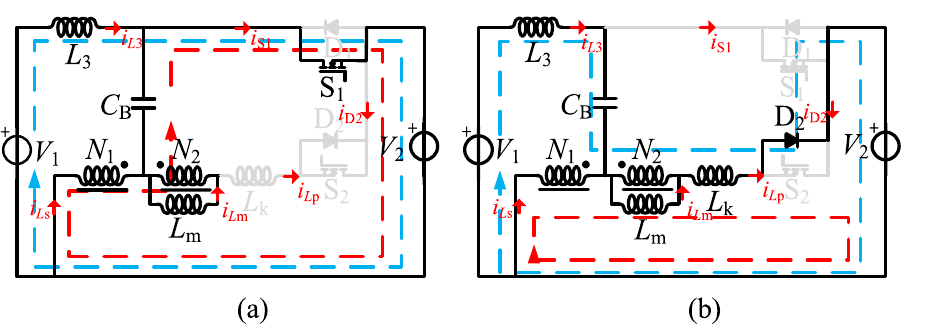
Figure 11. The equivalent circuit of the operation modes in the step-down mode, ( a ) S 1 on, ( b ) S 1